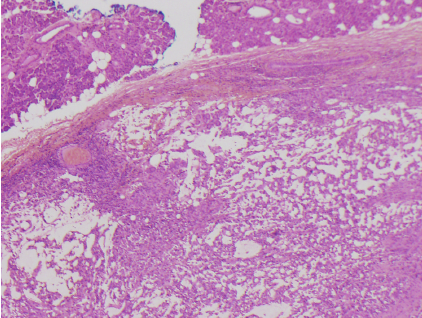
Figure 3: Tumour cells arranged in a loose lacelike pattern in a myxoid stroma. The margin is well defined in this area and normal salivary tissue is present in the upper right corner (H&E × 20).